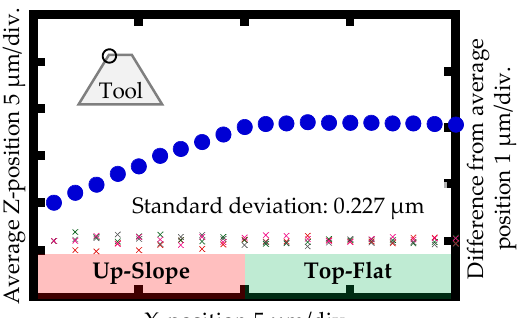
Figure 11. The left edge (including Up-slope and Top-Flat) of a cutting tool with a slope angle of 45° measured by the double-sided beam probe.